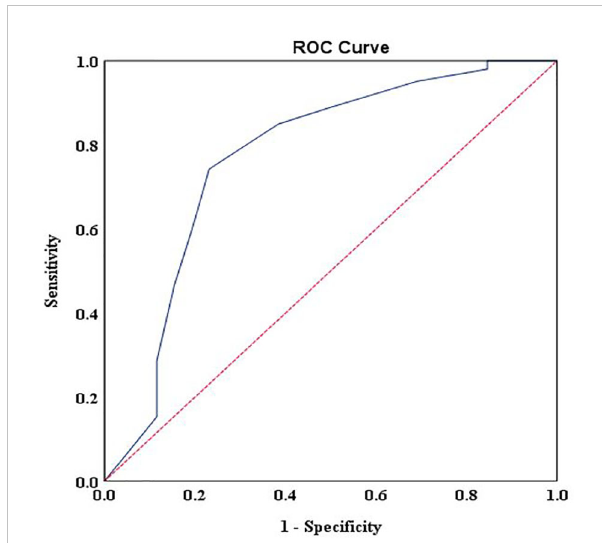
FIGURE 1 Receiver operating characteristic curve of the distress thermometer score against the Hospital Anxiety and Depression Scales-Total cutoff score > 15 for patients with advanced stages.